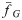
Scatter plots, by treatment, of native tolerance (f¯G) and migrant tolerance (f¯B) against native share of the population (NatShare), in steady-state at t = tmax.